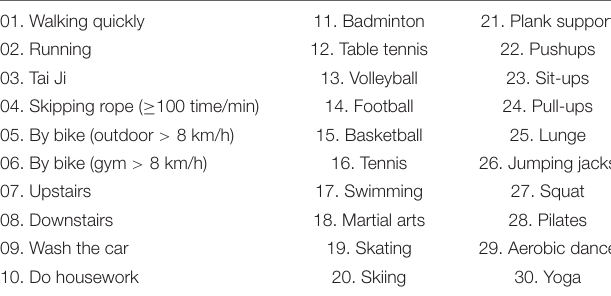
TABLE 2 | List of physical activities available to participants.